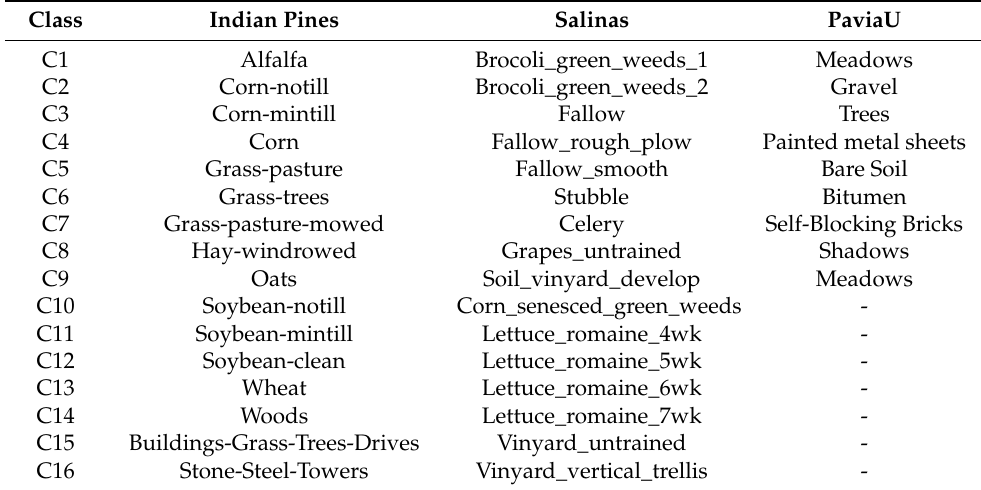
Table 1. The results of five indicators on three pubic